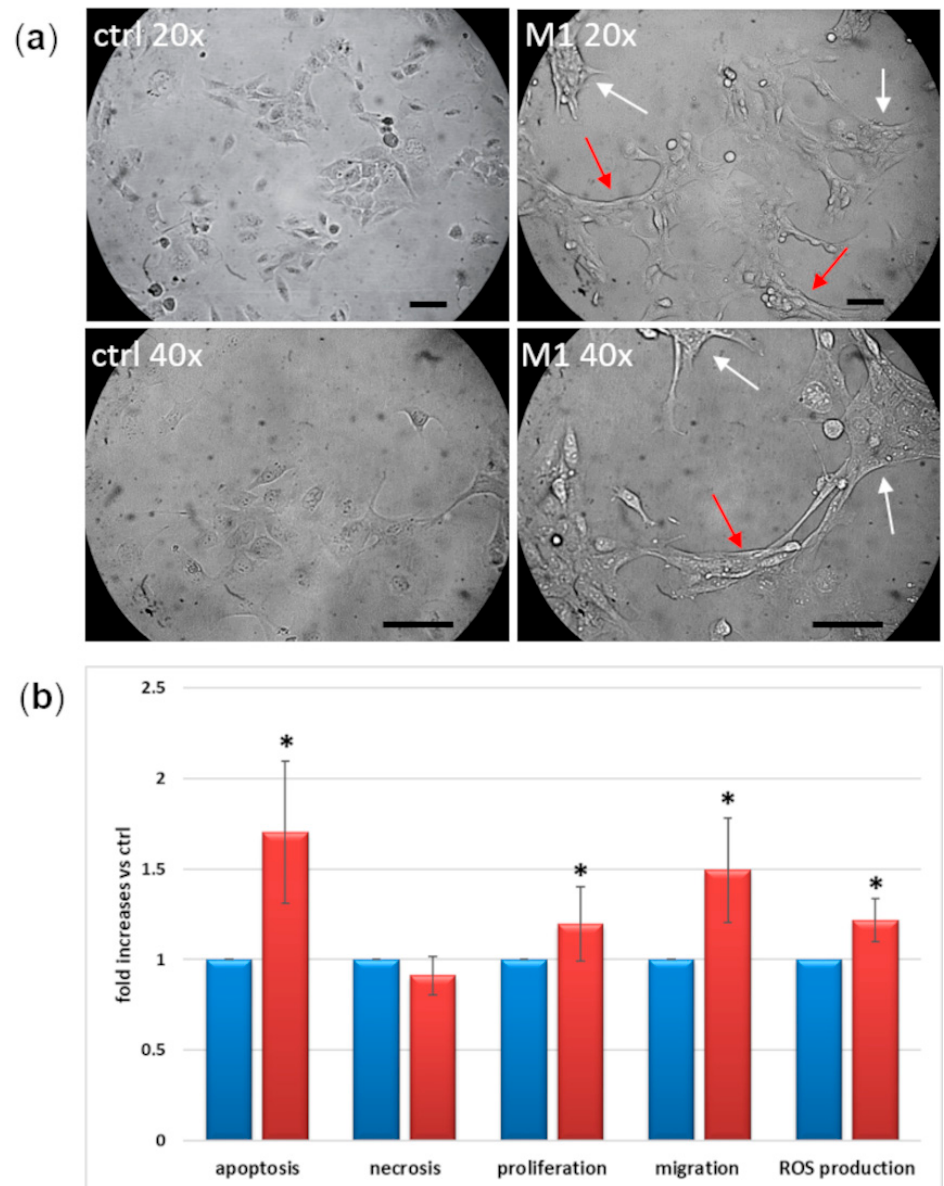
Figure 5. Functional changes of IM-HM cells after 24 h M1 exposure: ( a ) morphological aspect: comparison between physiological conditions (ctrl) and M1. M1 cells assume an amoeboid shape (white arrows) and form tubular structures (red arrows), characteristic of activated cells. Images were taken at 20x or 40x objective magnification, and scale bar indicates 50 μ m; ( b ) apoptosis, necrosis, proliferation, migration, and reactive oxygen species (ROS) production in control (blue) and M1-activated (red) cells. M1 activation was achieved by exposing microglial cells for 24 h to TNF α 10 ng/mL + IL1 β 20 ng/mL + IFN γ 50 ng/mL. Mean of five experiments ± SD, * p < 0.05.